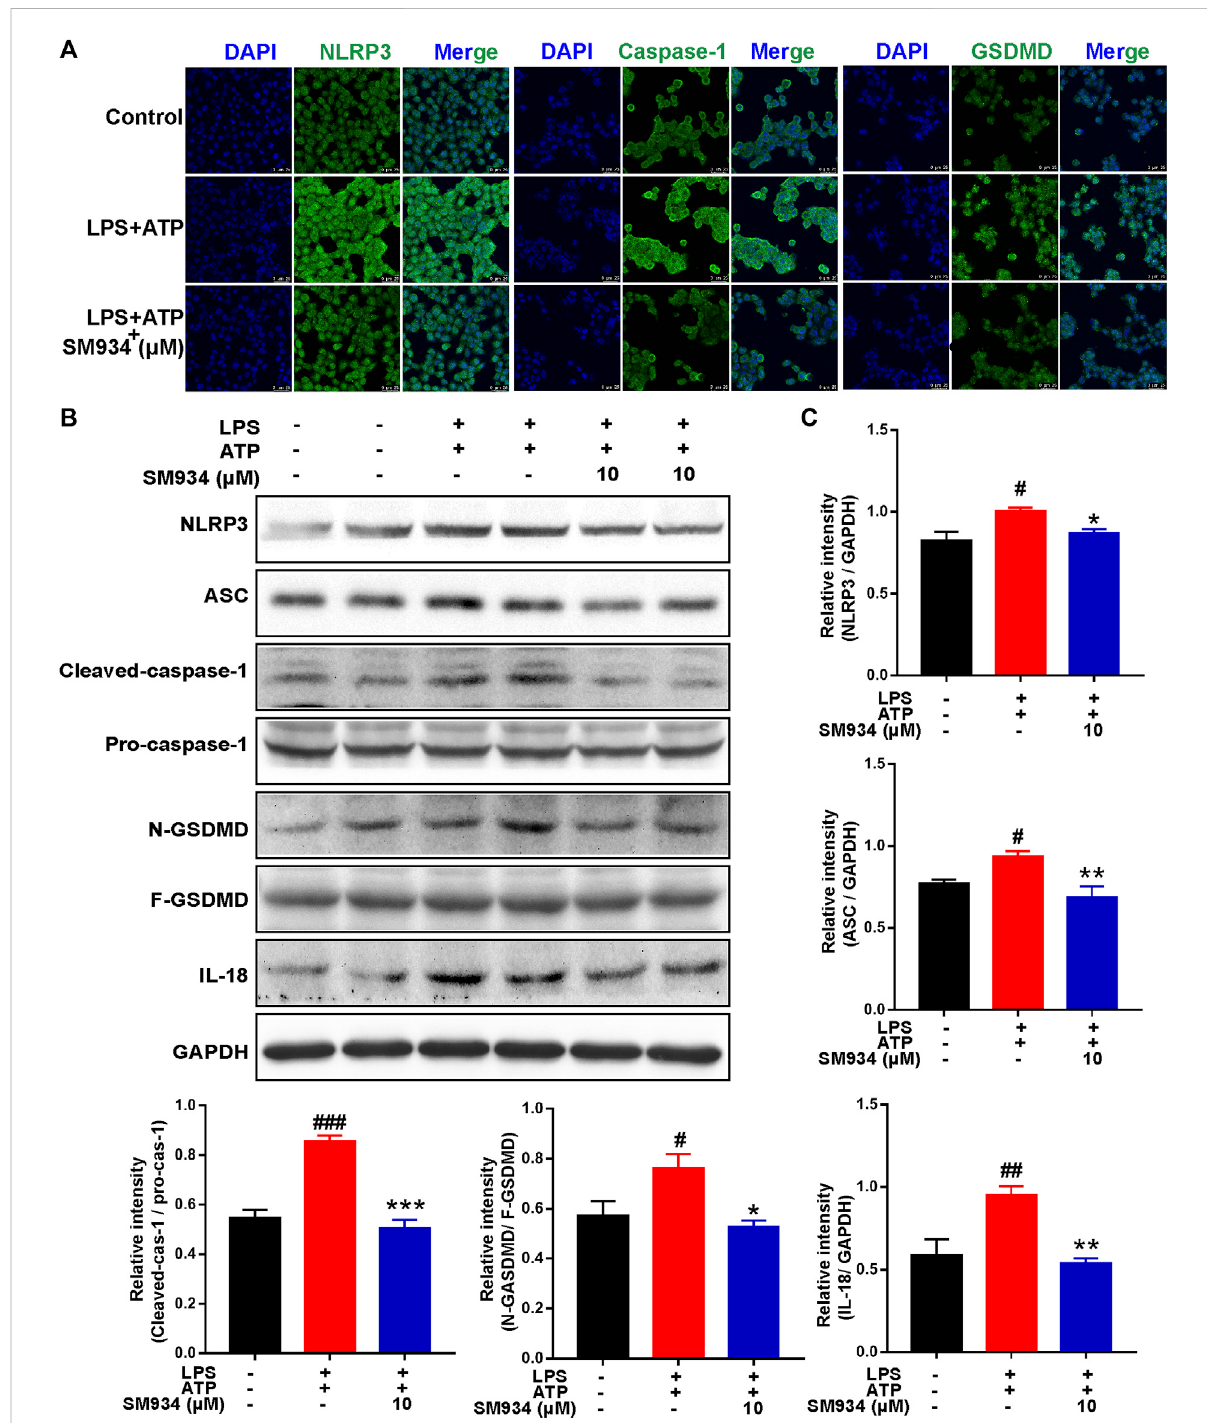
SM934 reduced the epithelial pyroptosis through preventing the activation of NLRP3/caspase-1/GSDMD signals in vitro . HT-29 cells were treated with LPS (1 μ g/ml) for 12 h, and then treated with ATP (5 mM A) for 2 h to induce pyroptosis without or with SM934 (cells pro-cultured with SM934for1 h). (A) Immuno fl uorescencestainingwasperformedtodetecttheformationofNLRP3,caspase-1,andGSDMDinHT-29cells(scalebar, 25 µm). (B) Protein levels of NLRP3, ASC, caspase-1 (p45, p20), GSDMD-F and GSDMD-N, and IL-18 examined by immunoblotting in HT-29 cells. (C) Relative intensities of proteins were also conducted. Data are shown as means ± SEM from three representative experiments. # p < 0.05, ## p < 0.01, and ### p < 0.001 vs . control group; * p < 0.05, ** p < 0.01, and *** p < 0.001 vs . LPS and ATP